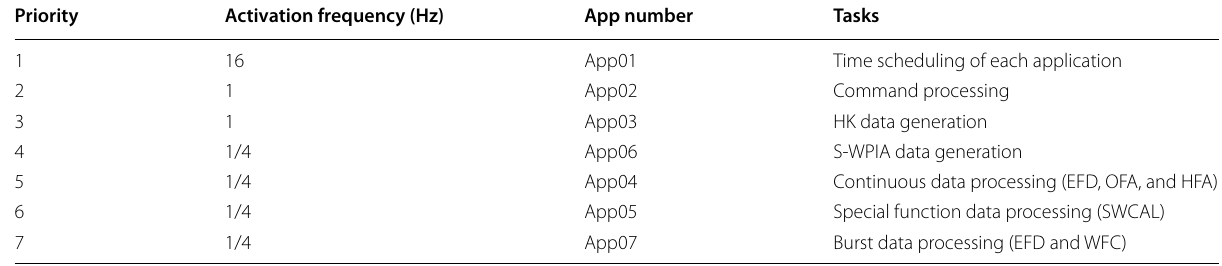
Table 1 Priority, activation frequency, and assigned tasks of each application layer